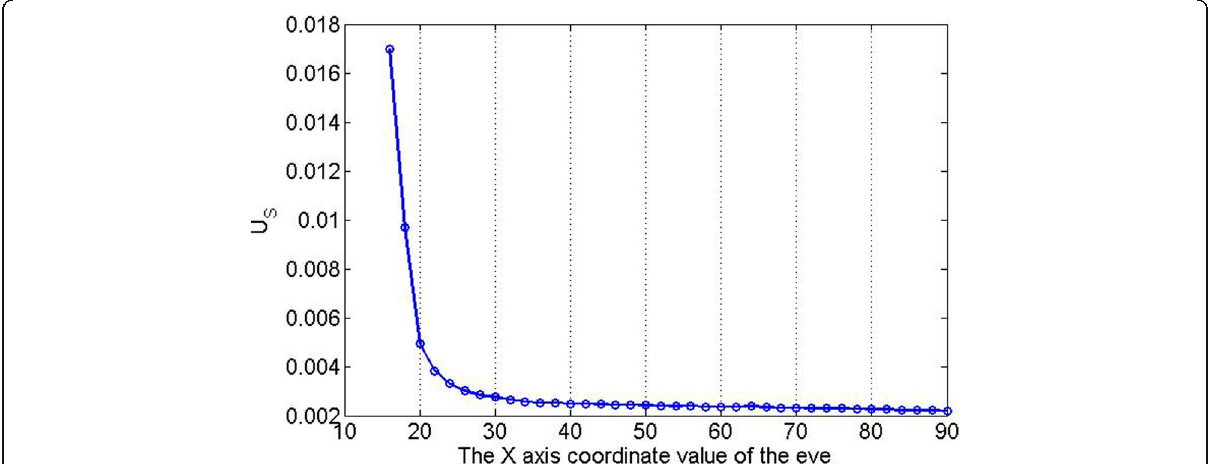
Fig. 5 The source node total payment U S Vs the location change of eavesdropping